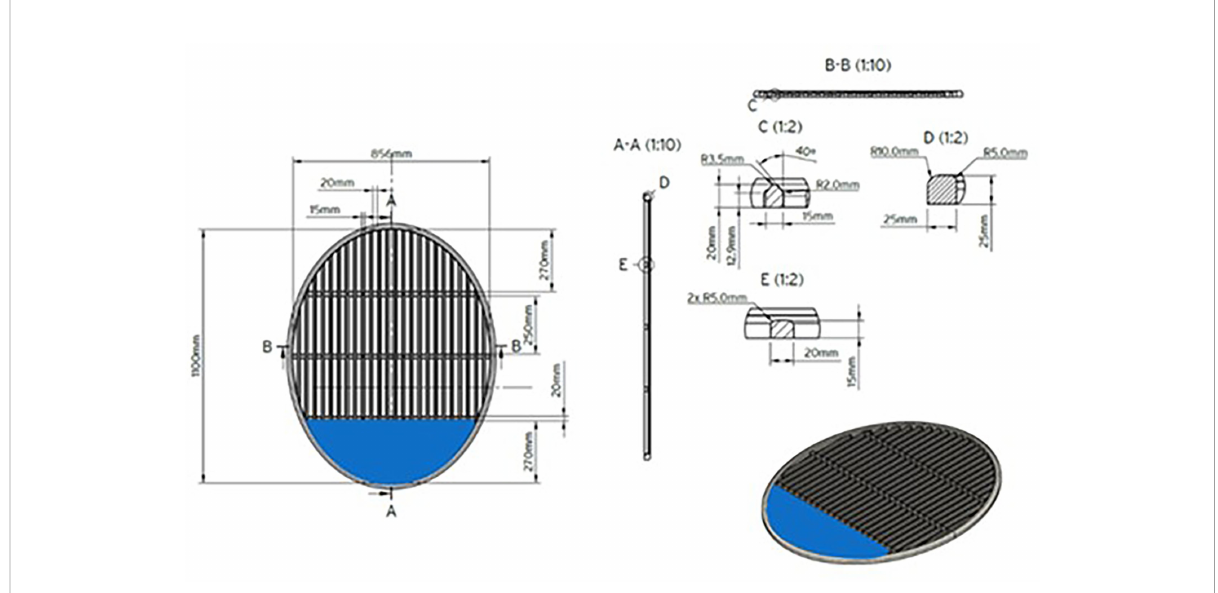
FIGURE 5 Scheme of the “ FLEXGRID ” , a juvenile selection grid employed for the sea trials. The blue area indicates the hole in the grid through which the commercial catch is diverted to the